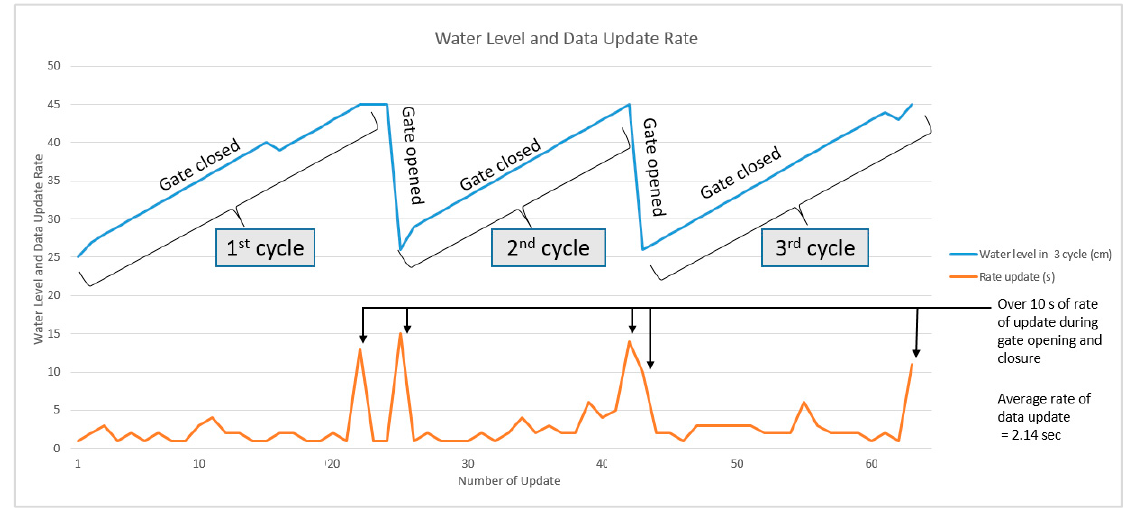
Figure 19. Gate V3 water level and data update rate.